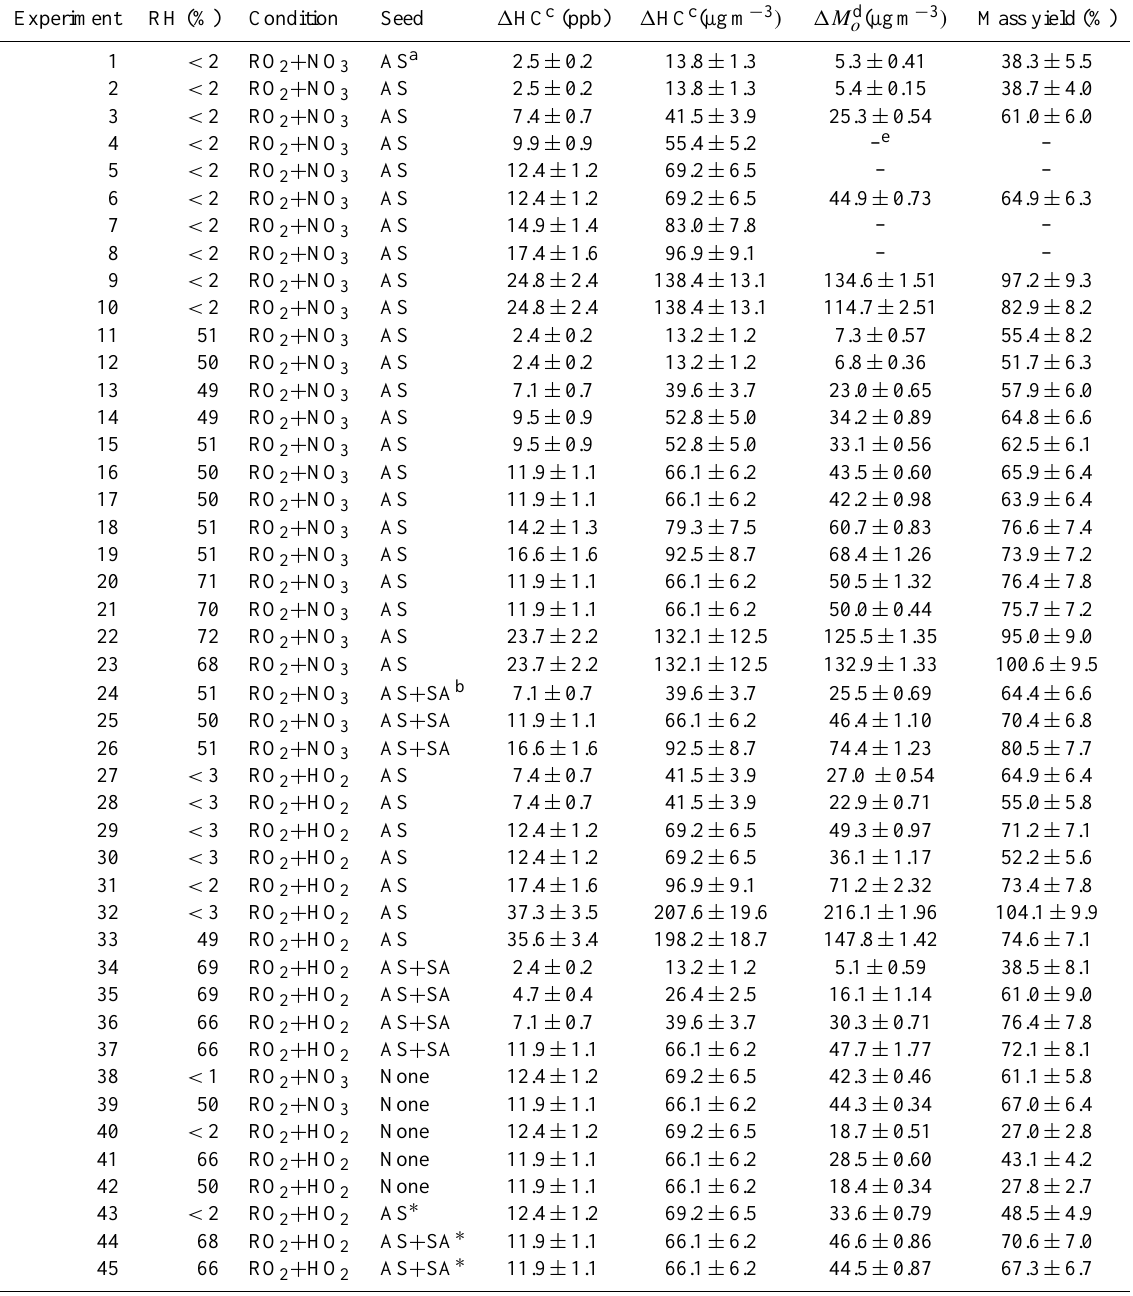
Table 1. Experimental conditions and aerosol mass yields for all experiments.